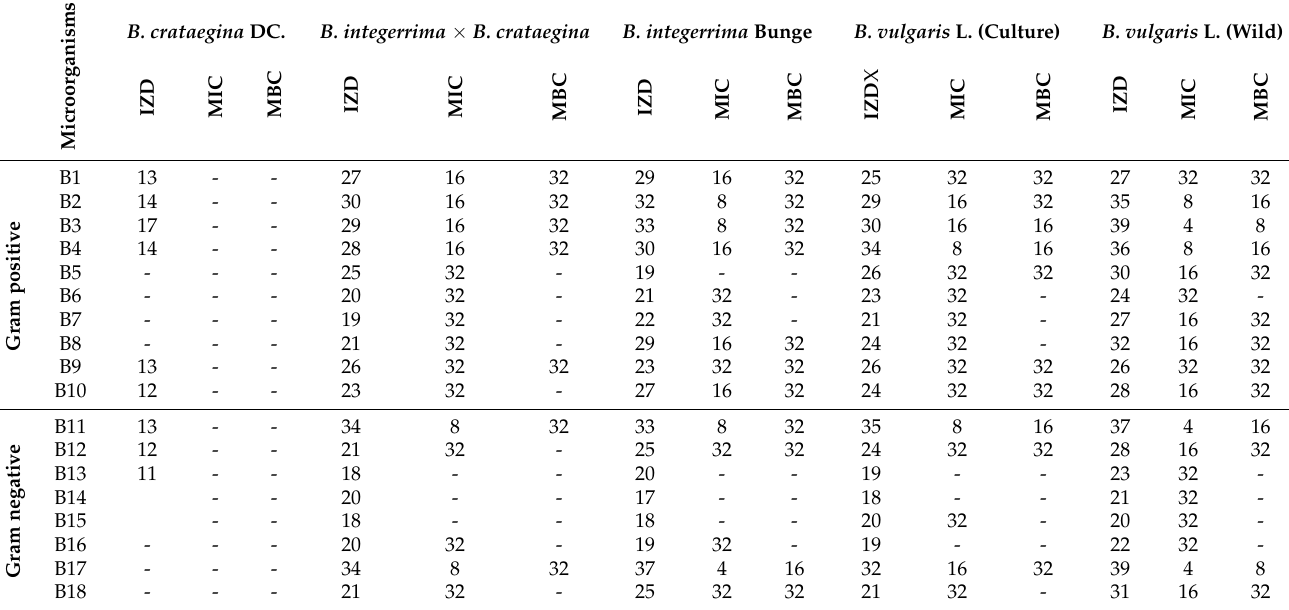
(Table 3). The obtained results showed that Berberis spp. fruit samples have an antibacterial effect. In addition, it is concluded that it may be beneficial to use these fruits as food supplements for phytotherapy. Table 3. Minimum inhibition concentration (mg/mL), minimum bactericidal concentration (mg/mL) and inhibition zone diameter (mm) of Berberis